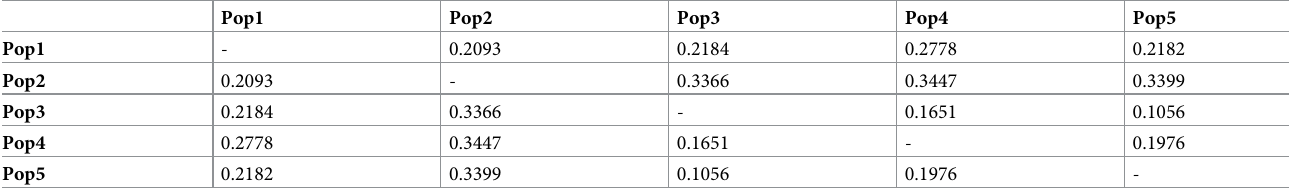
Table 6. Allele-frequency divergence among populations of V . stipulacea